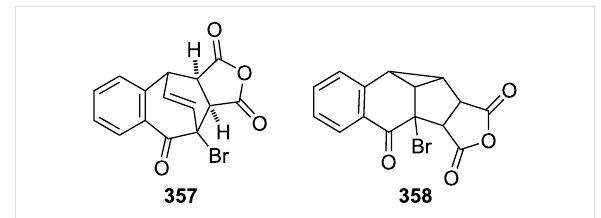
Figure 15: Cycloadduct 357 and its di- π -methane rearrangement product 358 .